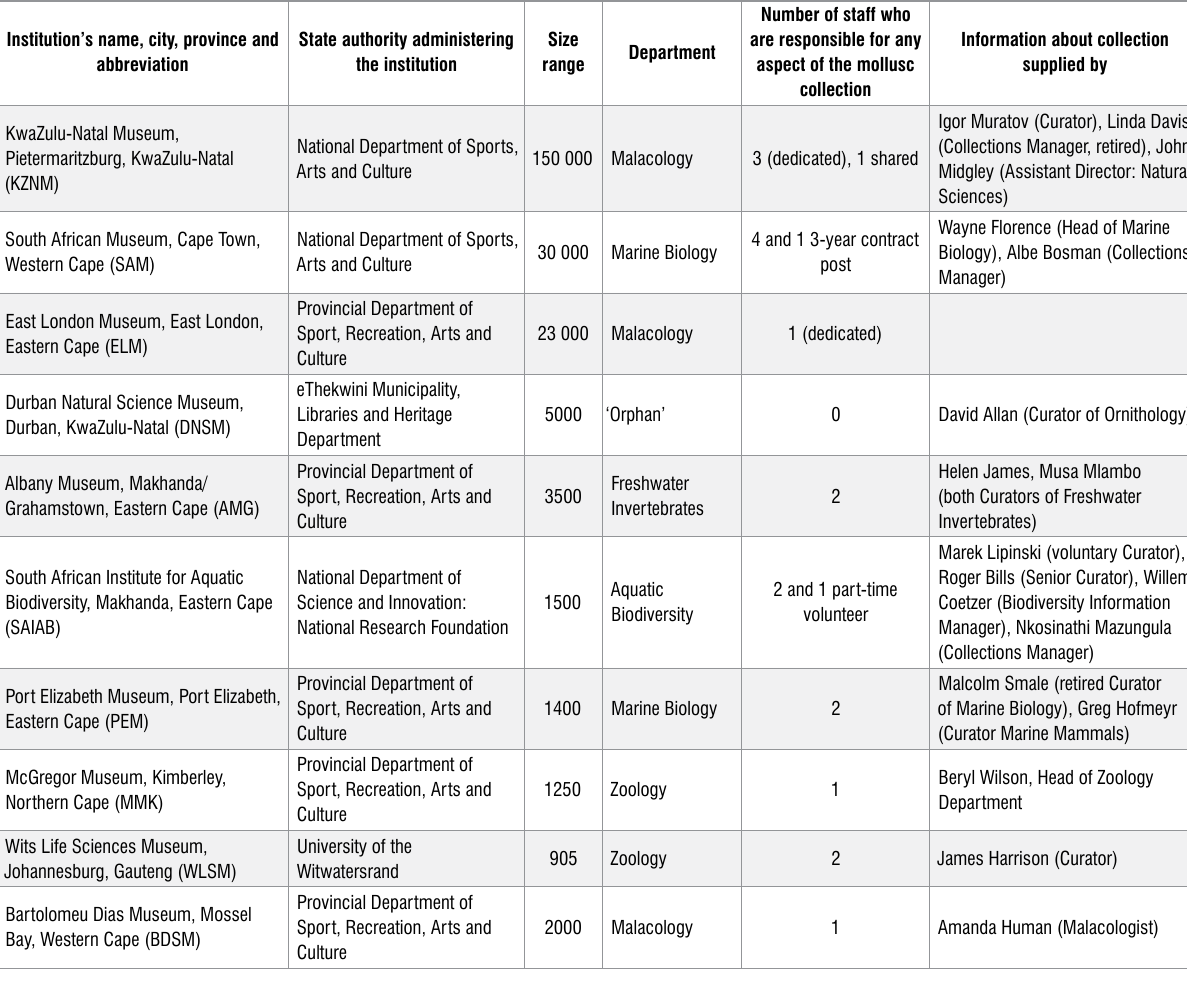
South African mollusc collections: locations, administering authorities and size ranges (catalogued lots)